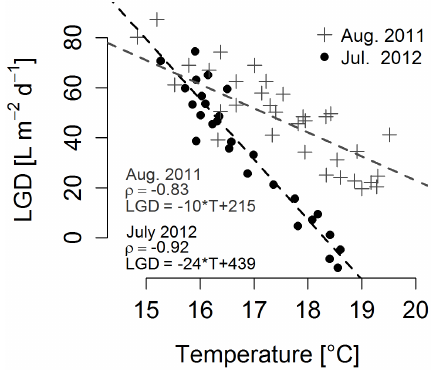
Figure 5. Sediment temperature measured 30cm below the sedi- ment lake interface during two different VTP surveys vs. LGD rates estimated from